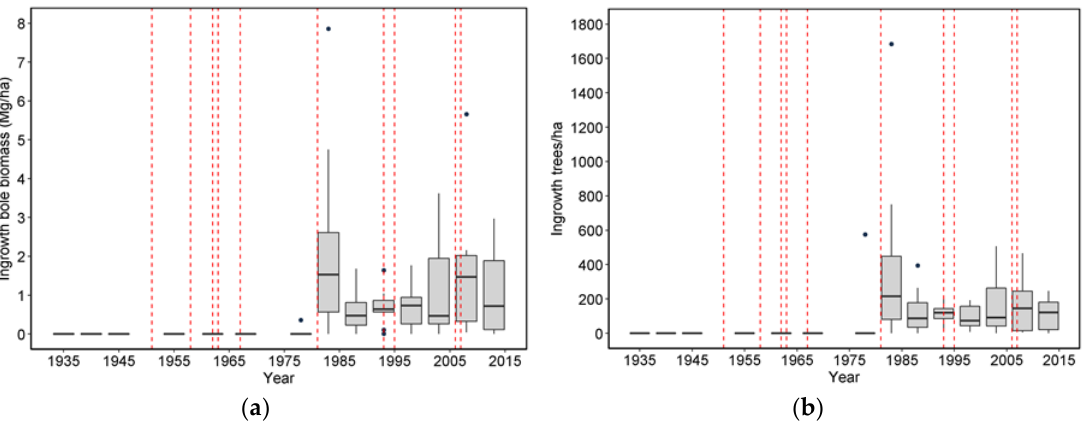
Figure 10. Median and range of ingrowth across ten permanent plots, expressed as bole biomass (Mg) per hectare ( a ), and trees per hectare ( b ). The red vertical lines indicate major wind events.